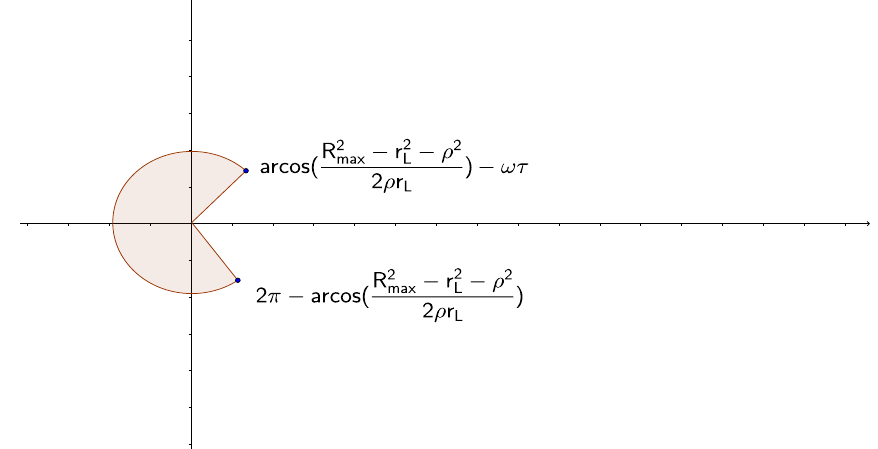
Figure 2. The shaded area shows the difference ψ − θ that satisfies Equation